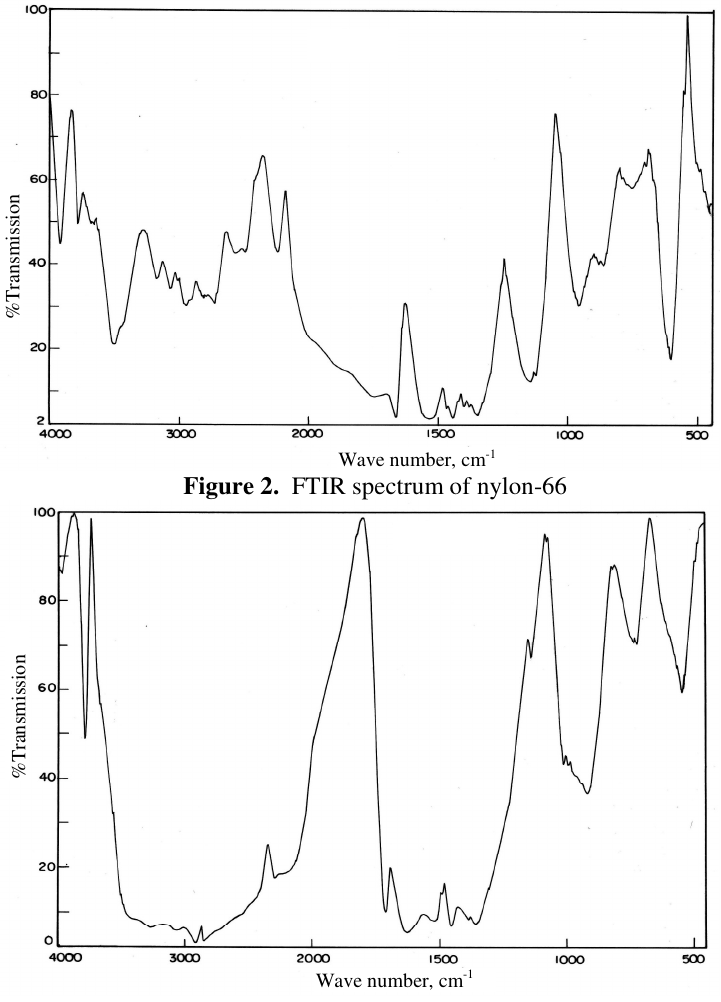
Figure 3. FTIR Spectrum of GF Nylon-66 Figure 3. FTIR spectrum of GF